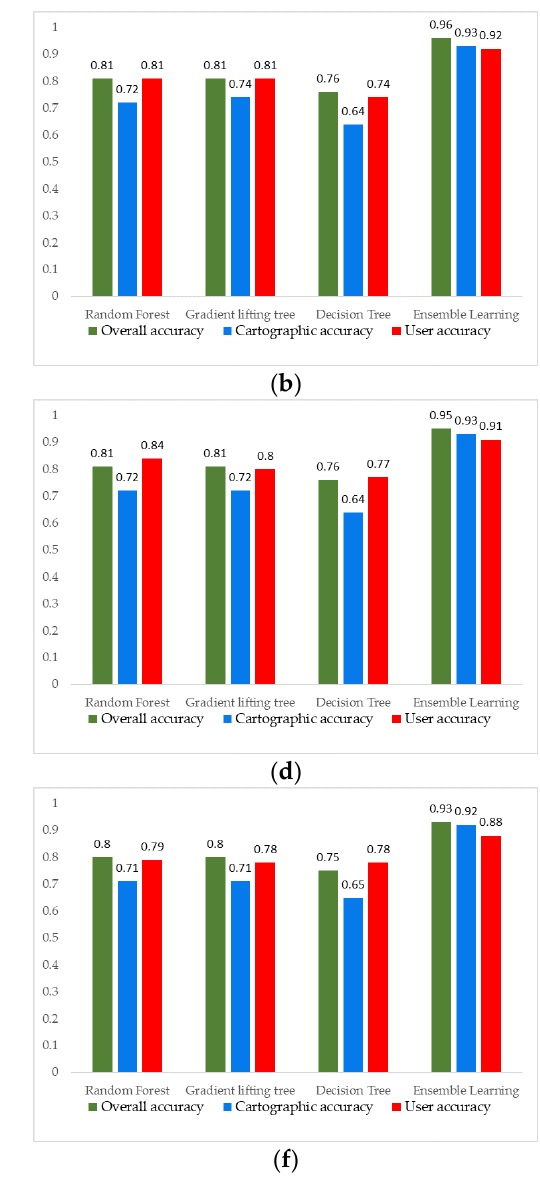
Figure 8. Accuracy evaluation graph of classifier. ( a ) Classifier accuracy evaluation graph in 2016; ( b ) classifier accuracy evaluation graph in 2017; ( c ) classifier accuracy evaluation graph in 2018; ( d ) classifier accuracy evaluation graph in 2019; ( e ) classifier accuracy evaluation graph in 2020; ( f ) average accuracy evaluation graph of classifier from 2016 to 2020.